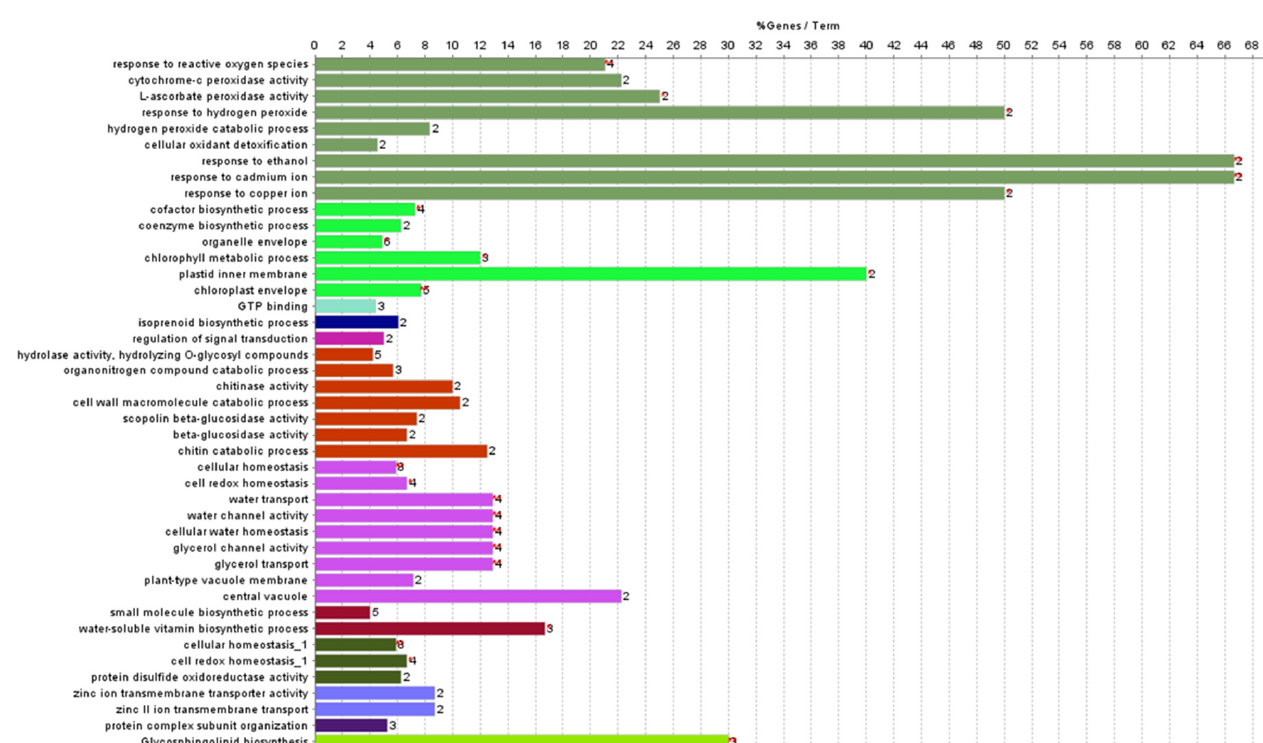
Figure 5. Genetic network of the genes upregulated in TR plants. Marked characteristics are anno- tated in Supplementary Table S4.